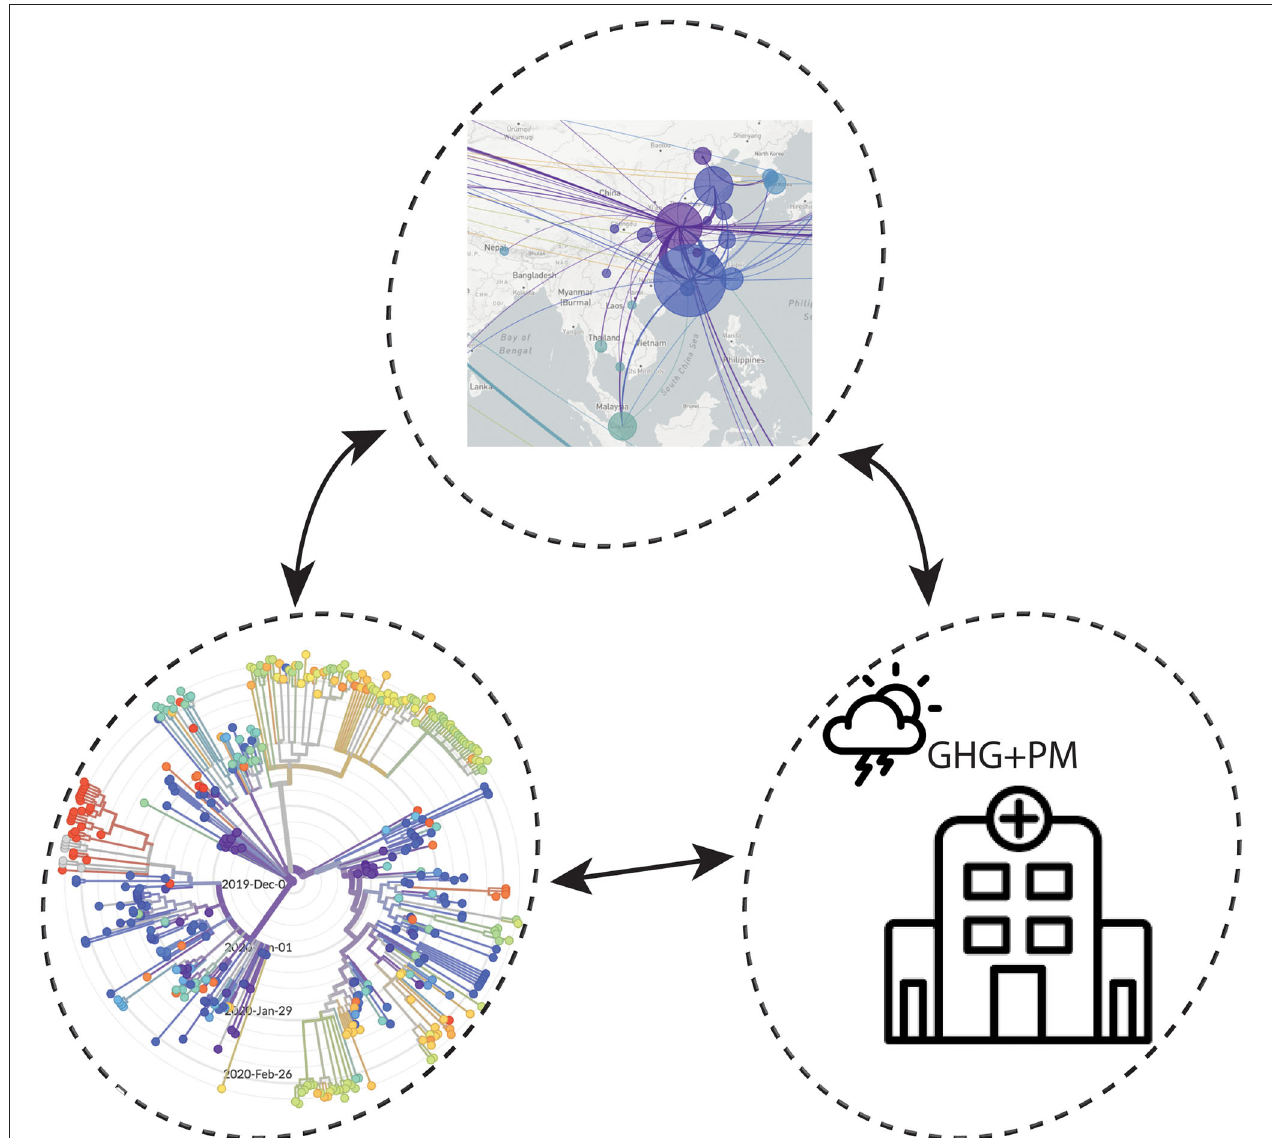
FIGURE 1 | Biocomplexity of COVID-19. The spread of COVID-19 worldwide manifested several ecological and evolutionary trajectories considering phylogenetic and socio-environmental determinants over space and time (including for instance climatological, air pollution, and healthcare factors underpinning vulnerability, exposure and control). Critical research and ecosystemic management of COVID-19 should consider the interdependencies of these factors underpinning novel and multidisciplinary areas such as eco-environmental phylogenetics and ecosystem health science. Phylogenetic tree and geographical spread map was made in https:// nextstrain.org/sars-cov-2/; other icons are used under license from